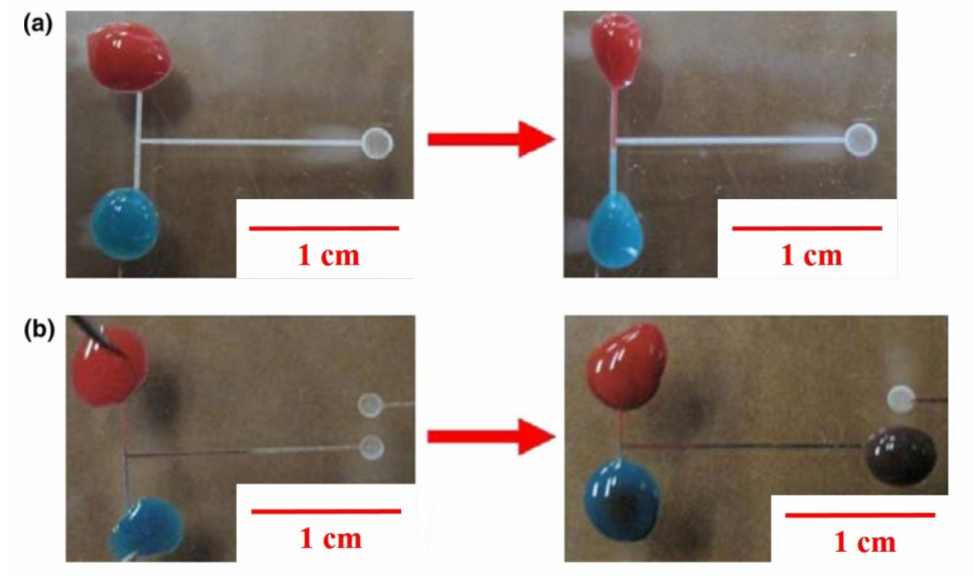
Figure 4. T-channel of PMMA microfluidic device using pigment to dye mixing test: ( a ) Directly in air, ( b ) assisted with metal